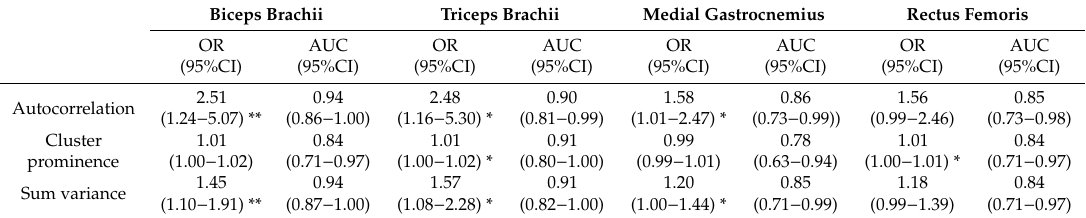
Table 3. The diagnostic performance of muscle texture parameter for dynapenia.